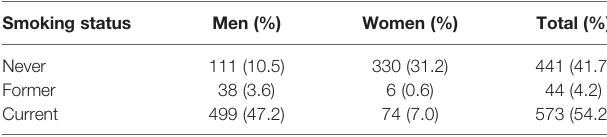
TABLE 1 | Characteristics of the discovery